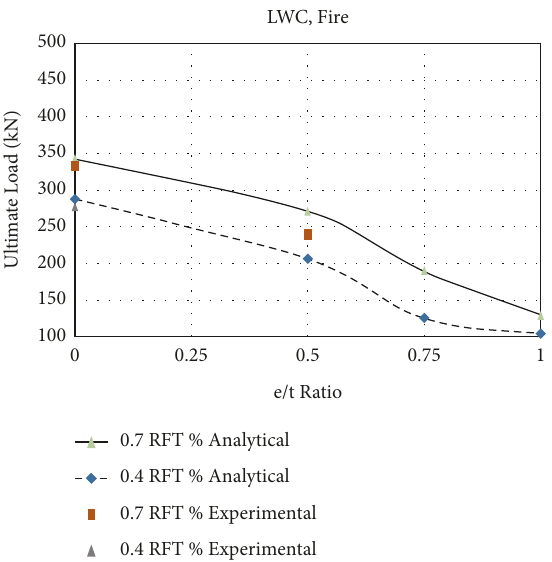
Figure 11: Effect of e / t ratio on the ultimate load for LWC when exposed to